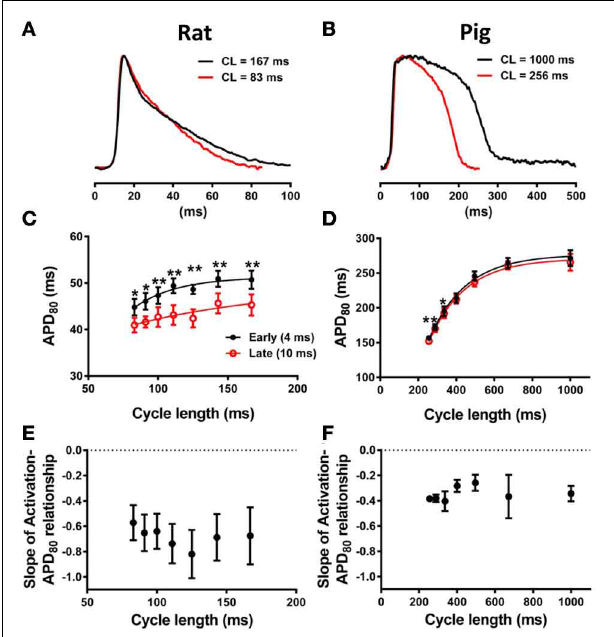
FIGURE 6 | Restitution properties of APD 80 and its dependence on AT. (A) Representative optical AP traces extracted from the same pixel location during pacing with cycle lengths, CL, of 167 and 83ms in rat. (B) Similarly, optical AP traces from pig paced at 1000 and 256ms cycle lengths are superimposed. Mean ± SD APD 80 from 4 and 10ms isochrones were plotted against pacing cycle length for rat (C) and pig (D) ( N = 7and N = 5, respectively). Statistical differences between APD across all pacing frequencies were determined by paired t -tests ( ∗ P < 0 . 05; ∗∗ P < 0 . 01). For comparison of the steepness of restitution, data were fitted with one-phase decay exponential curves. Mean ± SD of slopes of linear relationships between AT and APD 80 were plotted against pacing cycle length for rat (E) and pig (F) . One-way ANOVA was used to determine statistical data variance across pacing cycle lengths tested ( P < 0 . 05). No statistical deviations between means of slopes were observed for rat or pig.